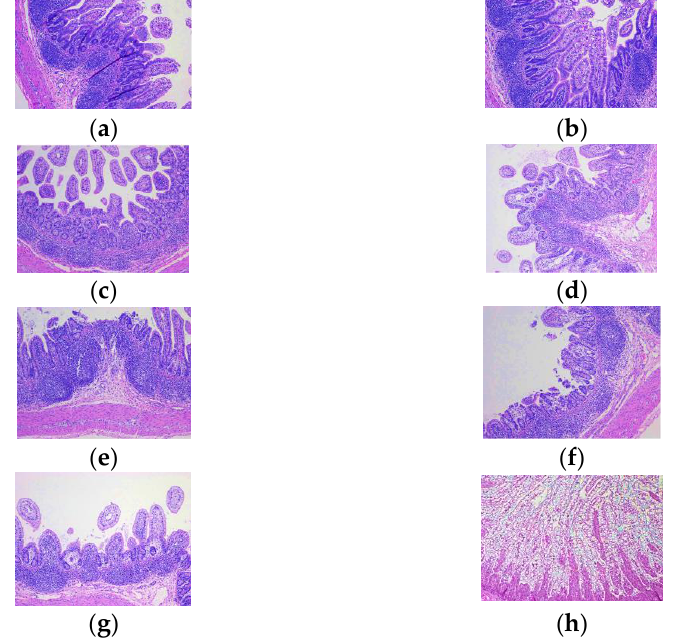
Figure 3. Hematoxylin and eosin-stained ileal lesions in Gn pigs following oral inoculation with Arg P[6] HRV. All tissues were collected at necropsy PID 2 or 3. ( A – G ) or mock ( H ). Villous blunting/atrophy ( A , C – G ), hydropic degeneration ( A ), and lymphoid hyperplasia ( A , B , D , E , G ) are present. Edema is also present in the lamina propria ( D ). ( H ) Normal ileum morphology of a mock-infected Gn pig. The magnification of images ( A – G ) is 100×, and the magnification for image H is 200×.